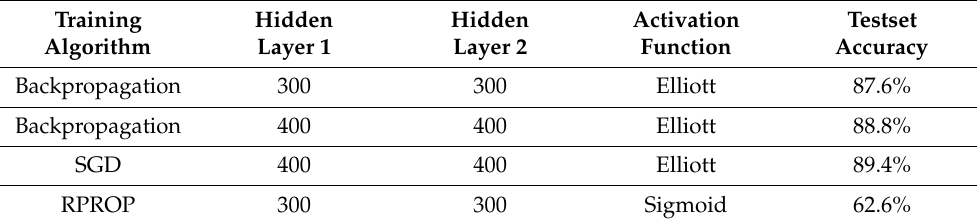
Table 2. Training NNs with 2 hidden